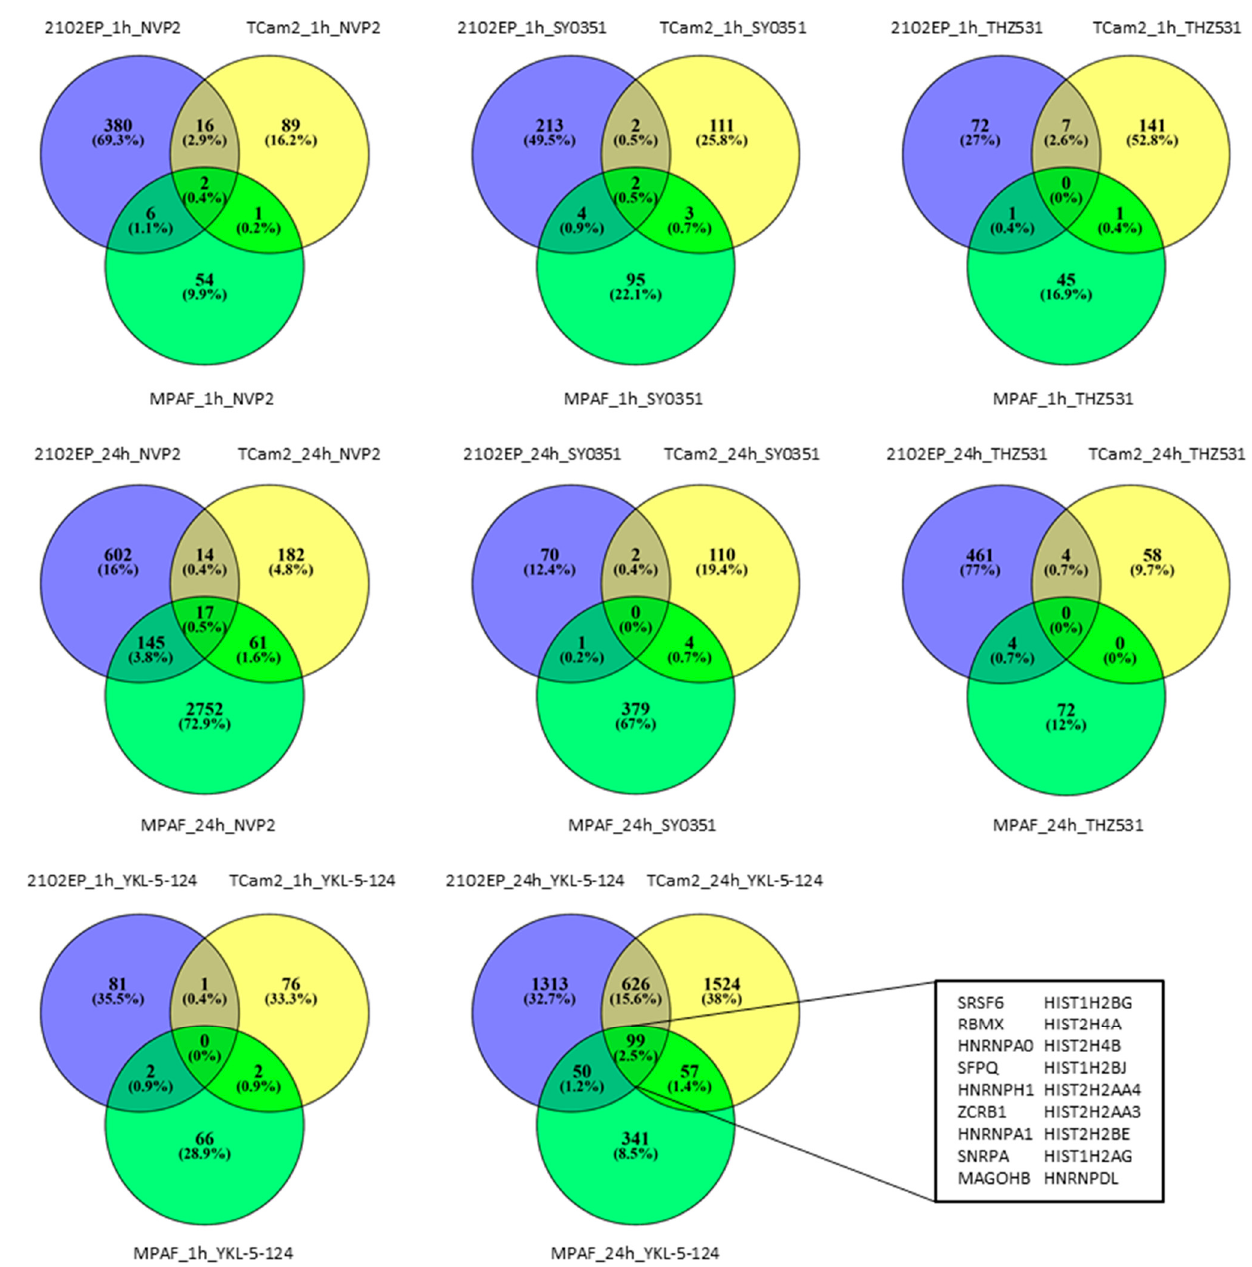
Figure 4. mRNA sequencing analysis revealed commonly deregulated genes in 2102EP, TCam2 and MPAF cell lines only after YKL-5-124 treatment. Significantly differential expressed genes were compared between the different cell lines individually for NVP2, SY0351, YKL-5-124 and THZ531. Selected commonly differential expressed genes are indicated for YKL-5-124 treatment (24 h). For all samples, n = 3.